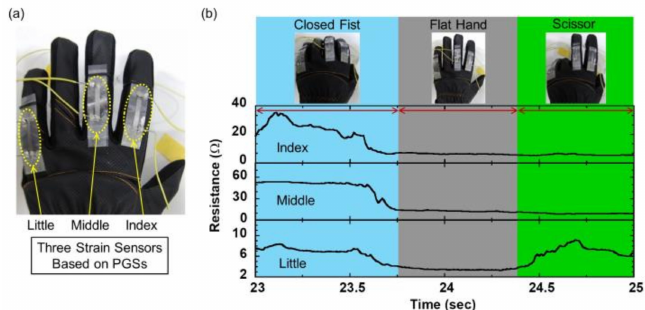
Figure 1. ( a ) Photographic images of data glove based on pyrolytic graphite sheets (PGSs). ( b ) Resistance versus time data for repetitive finger flexions.